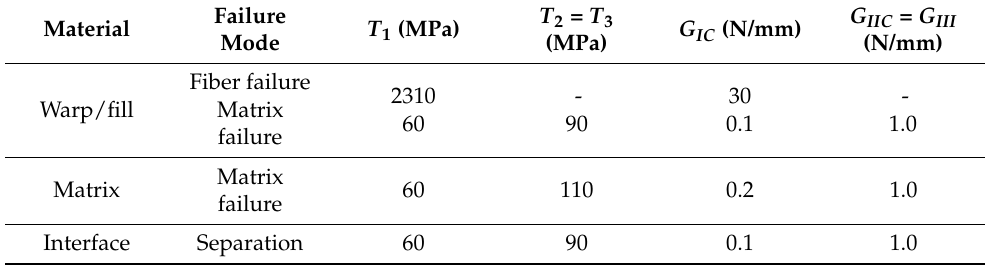
Table 3. Cohesive